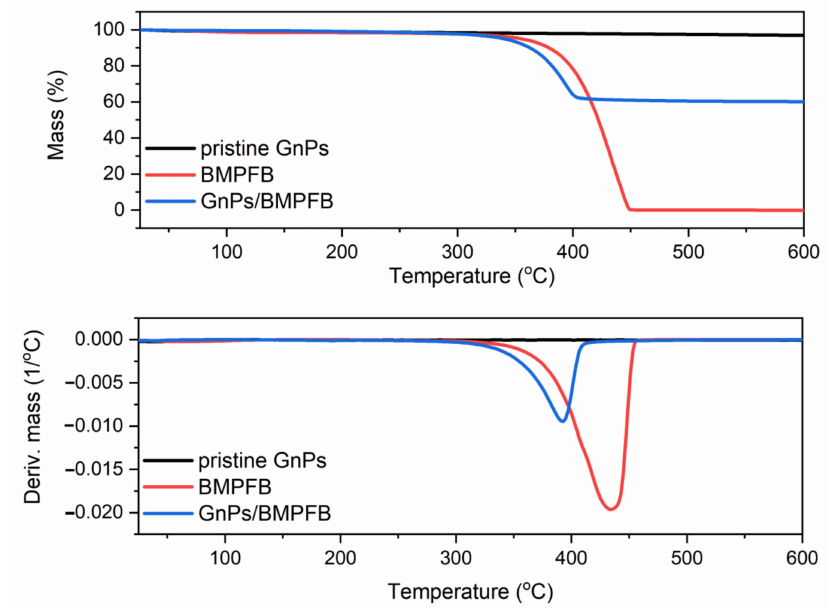
Figure 4. TG and DTG curves of BMPFB, pristine GnPs and GnPs modified with BMPFB from solution.